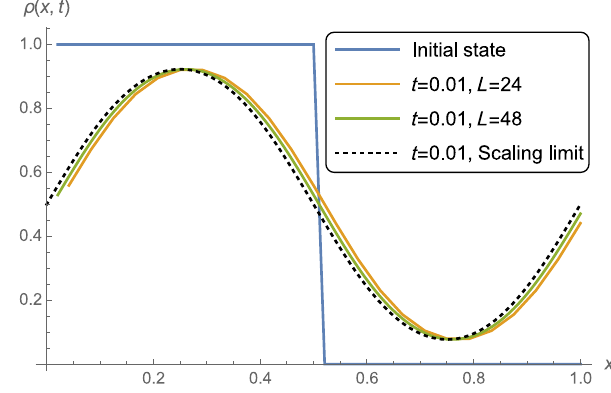
L 2 t Þ for system sizes Lx ð β 1 , and they do not fit L ¼ L ¼